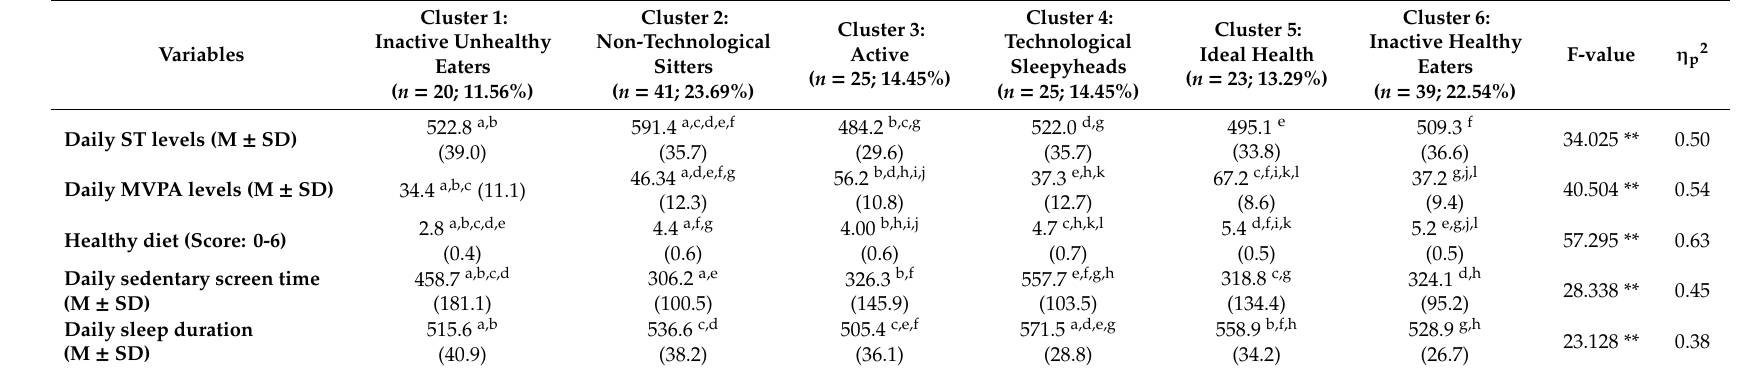
Table 3. Health-related behaviors for the six-cluster